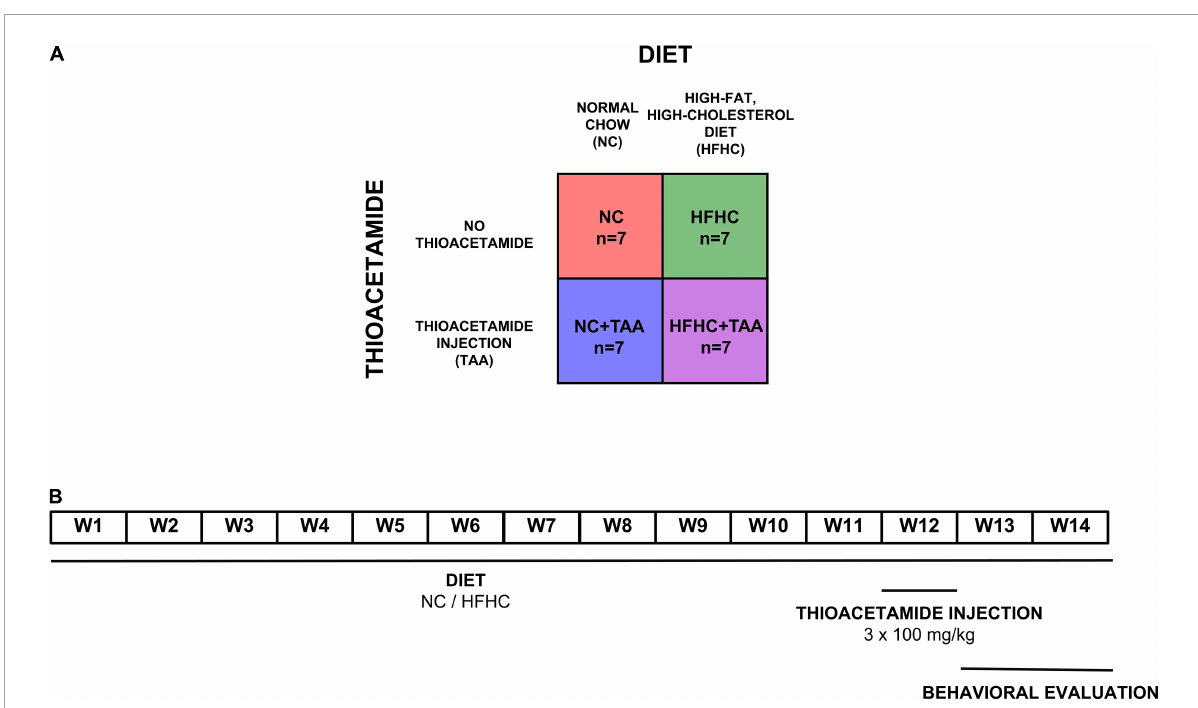
FIGURE1 Experimental design. (A) Experimental groups. Four groups ( n = 7 per experimental group) of male Sprague–Dawley rats were used. The NC group was dispensed a normal chow, the HFHC group was fed with a high-fat, high-cholesterol diet, the NC + TAA group received normal chow and thioacetamide (TAA) administration, and the HFHC + TAA group received both high-fat high-cholesterol diet and TAA. (B) Timeline of the experiment. Each group was administrated their respective diets for 14 weeks. On week 12, NC + TAA and HFHC + TAA received daily 3 injections of thioacetamide at a concentration of 100 mg/kg, making a total amount of 300 mg/kg. The behavioral evaluation started on week 13 to week 14 at the end of which the animals were sacrificed and the samples were collected.